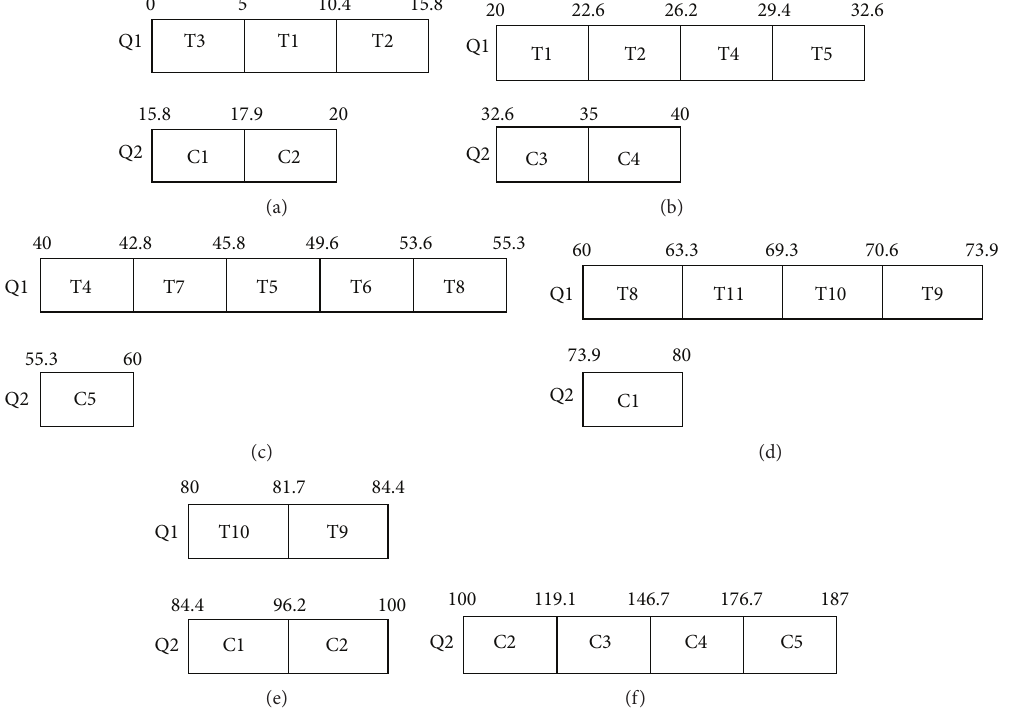
Figure 9: (a) 1st cycle of CPU (VMLQ), (b) 2nd cycle of CPU (VMLQ), (c) 3rd cycle of CPU (VMLQ), (d) 4th cycle of CPU (VMLQ), (e) 5th cycle of CPU (VMLQ), and (f) 6th–10th cycles of CPU (VMLQ).